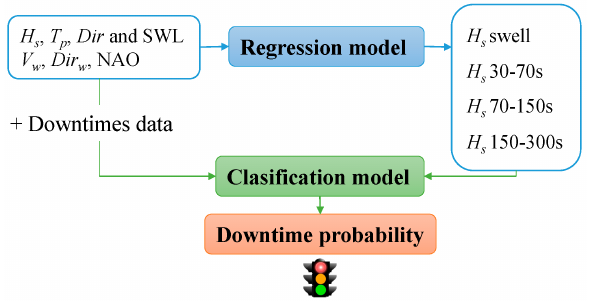
Figure 2. Flowchart of the proposed method to estimate downtime probability.